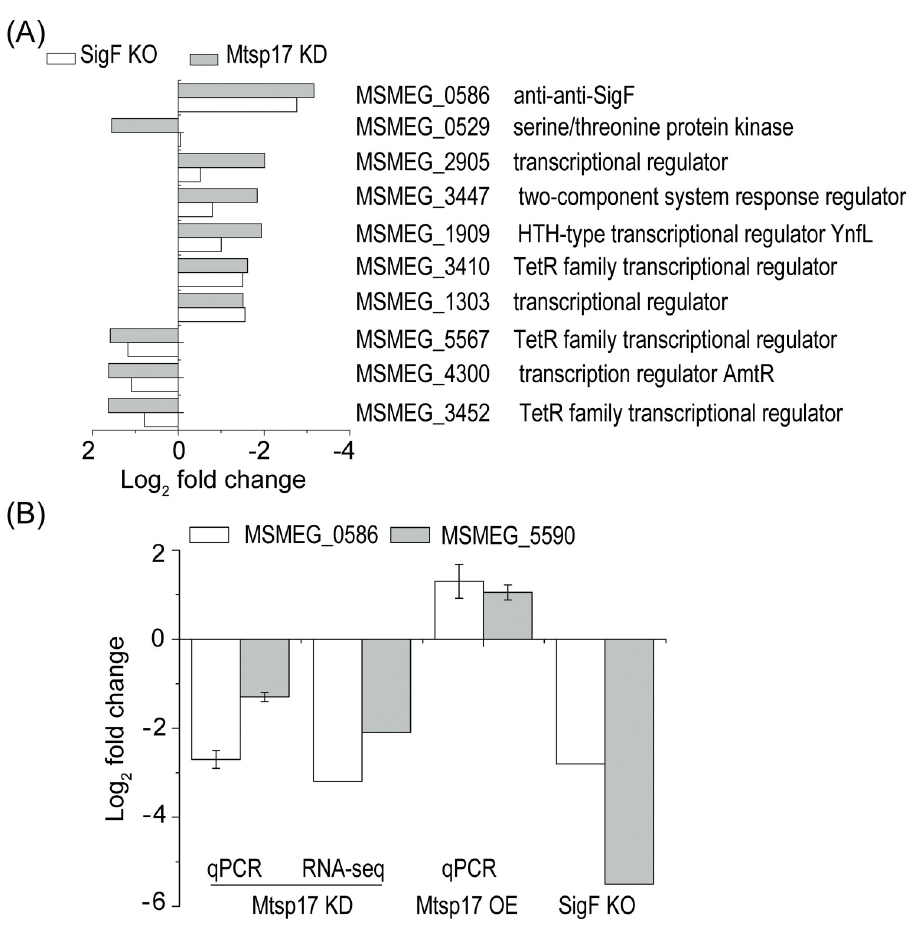
Fig 4. Comparisons of gene expression in Mtsp17 and SigF mutants. (A) 10 differentially expressed genes with log 2 fold change > 1.5 that are involved in transcriptional regulatory mechanisms and showed the same varying tendency in the SigF knockout (SigF KO) and conditional Mtsp17 knockout (Mtsp17 KD) strains. (B) Fold changes of MSMEG_0586 (anti-anti-SigF) and MSMEG_5590 mRNA in the conditional Mtsp17 knockout (Mtsp17 KD), Mtsp17 over-expression (Mtsp17 OE) and SigF knockout (SigF KO) strains. Data of the SigF knockout strain are from GSE19774.